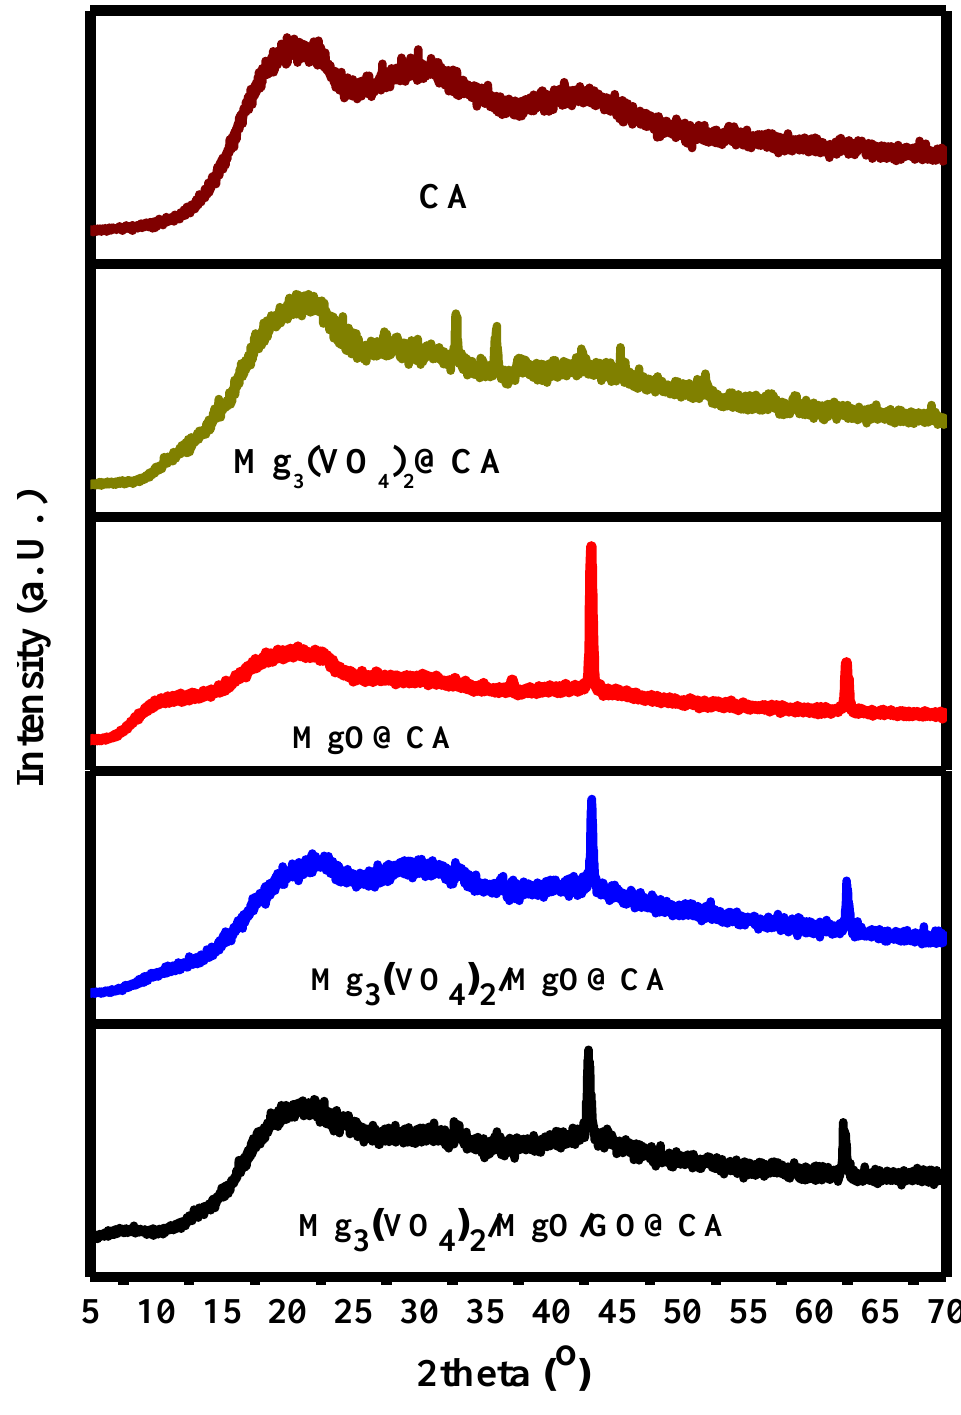
Figure 1. XRD analysis of CA-based films.